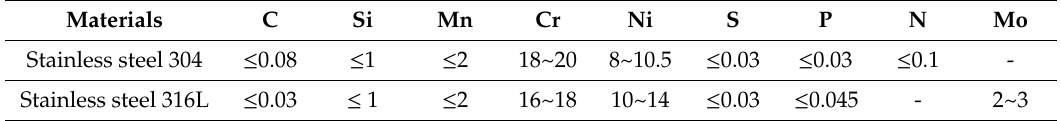
Table 1. Material characteristics of the base plate and welding wire.